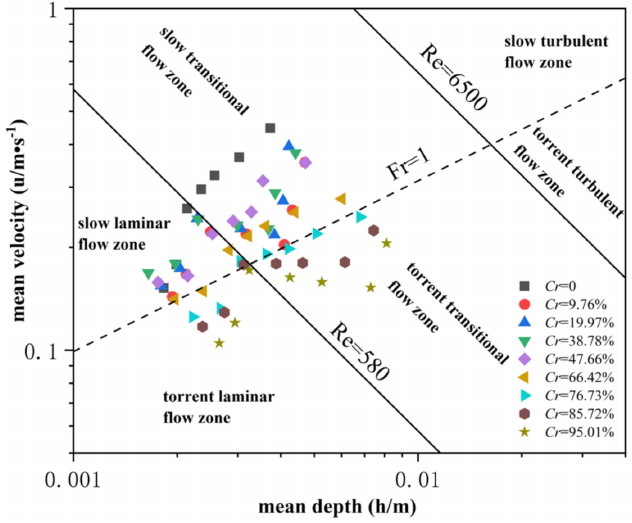
Figure 12. Flow regime under different degrees of vegetation